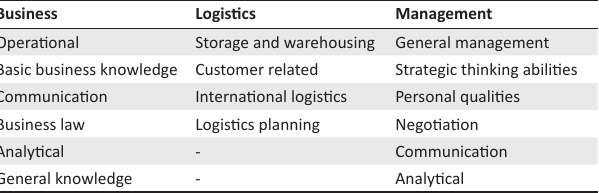
TABLE 6: Subgroups of the business logistics management